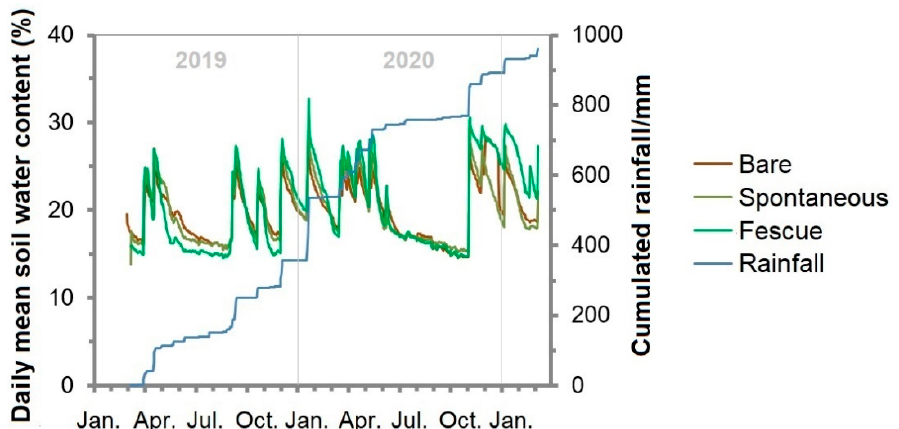
Figure 3. Daily mean soil water content at 5–10 cm depth in the different treatments along with the cumulated rainfall during the monitoring time.